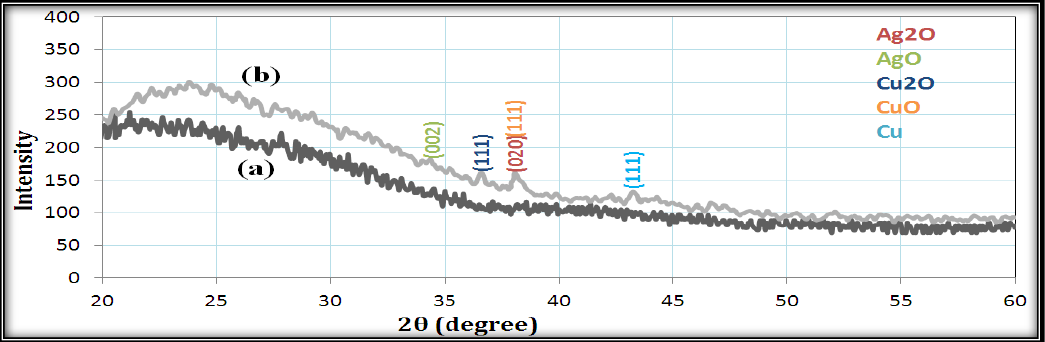
Cu O film at sintered at 600 °C (a) deposited at 2 2 4